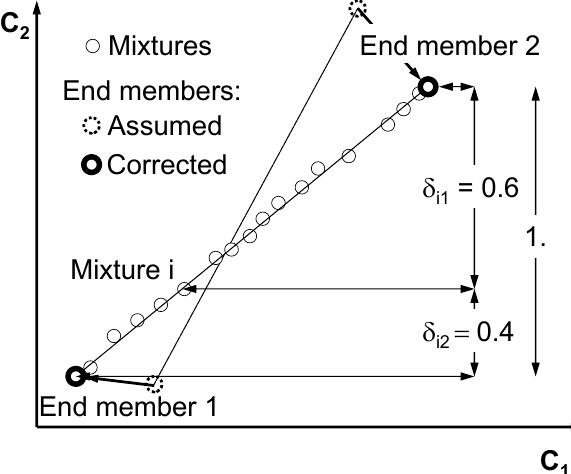
Fig. 1. Schematic representation of mixing calculations with uncer- tain end-members. Source 1 contains 1000mg/L of Chloride (Cl). Source 2 contains 0 mg/L of Cl. A measurement of 400mg/L im- plies that 40% of the water in the sample is coming from source 1, while 60% is coming from source 2. Mixtures concentration data are often affected only by measurement errors, much smaller than uncertainties of end-member concentrations. The latter can be cor- rected to be consistent with mixtures prior to conventional mixing